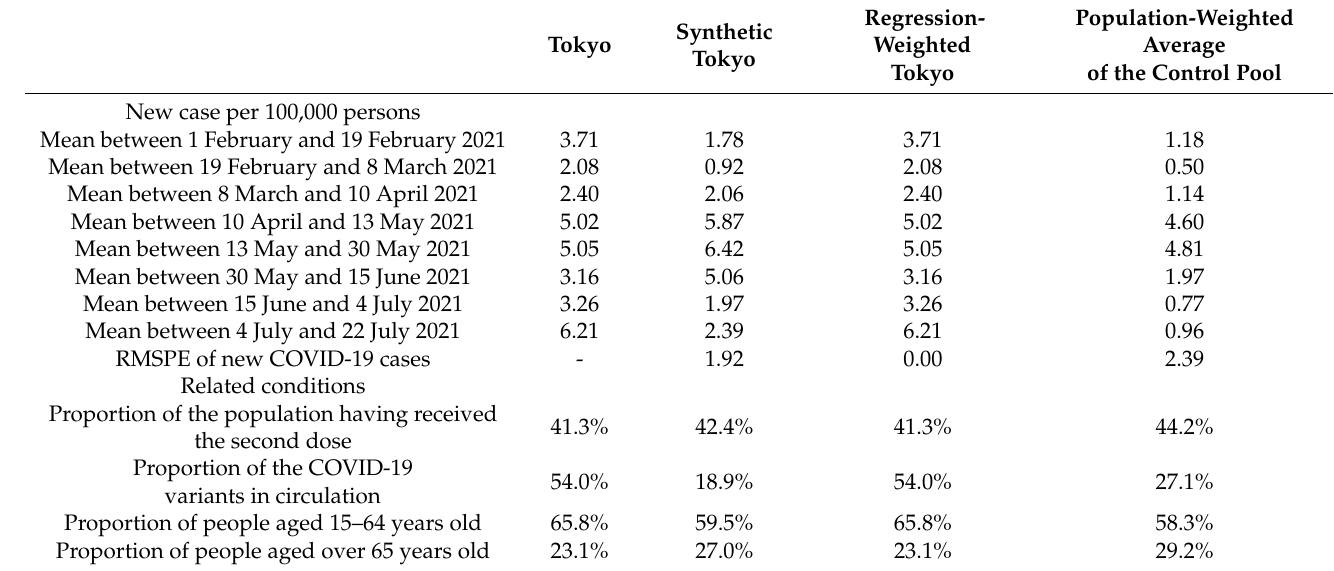
Table 2. Predictor means before the Tokyo 2020 Olympic and Paralympic